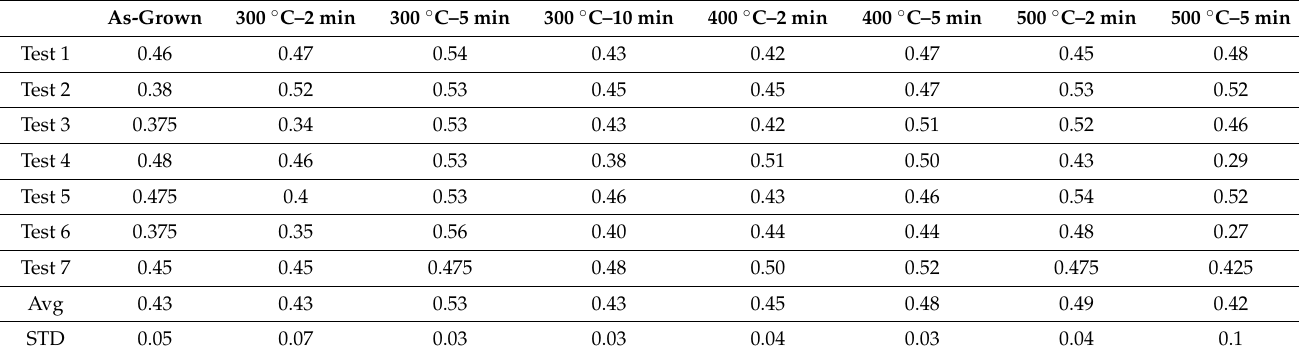
Table 3. Hysteresis data of tested devices.